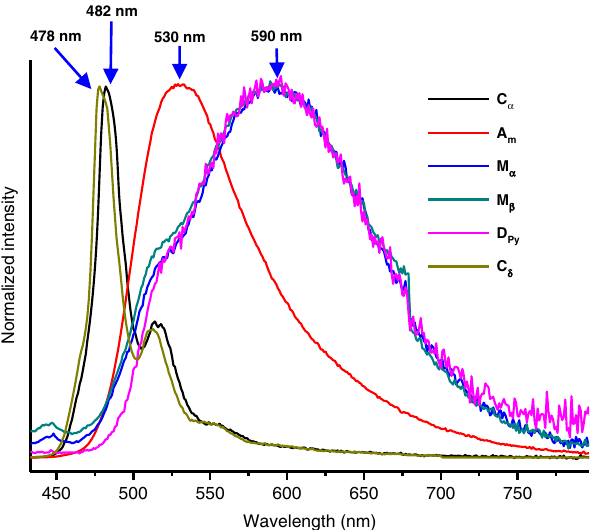
Fig. 3 Normalized emission spectra of various solid forms considered in this study. The spectra of C α , A m , M α , M β , D Py , and C δ are shown ( λ em = 365 nm).